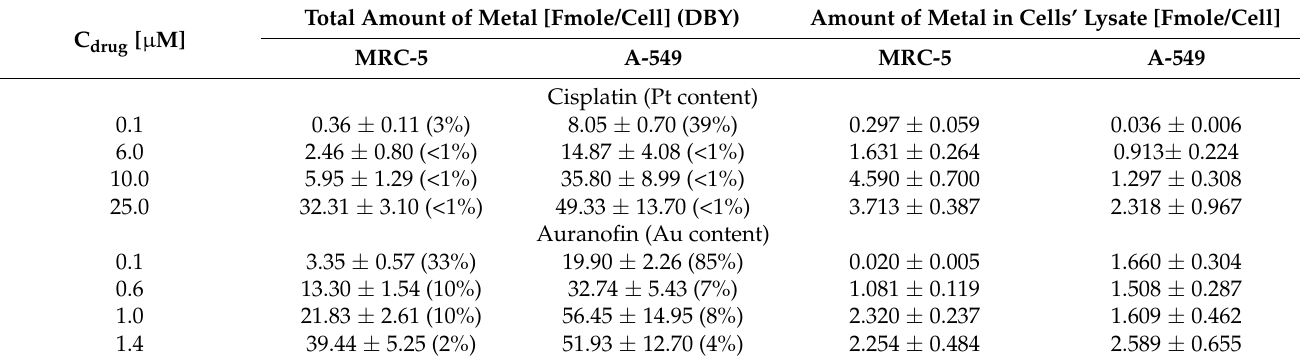
Table 2. Amounts of gold and platinum established for cells’ mineralizate and lysate (water-soluble compounds). C drug [ µ